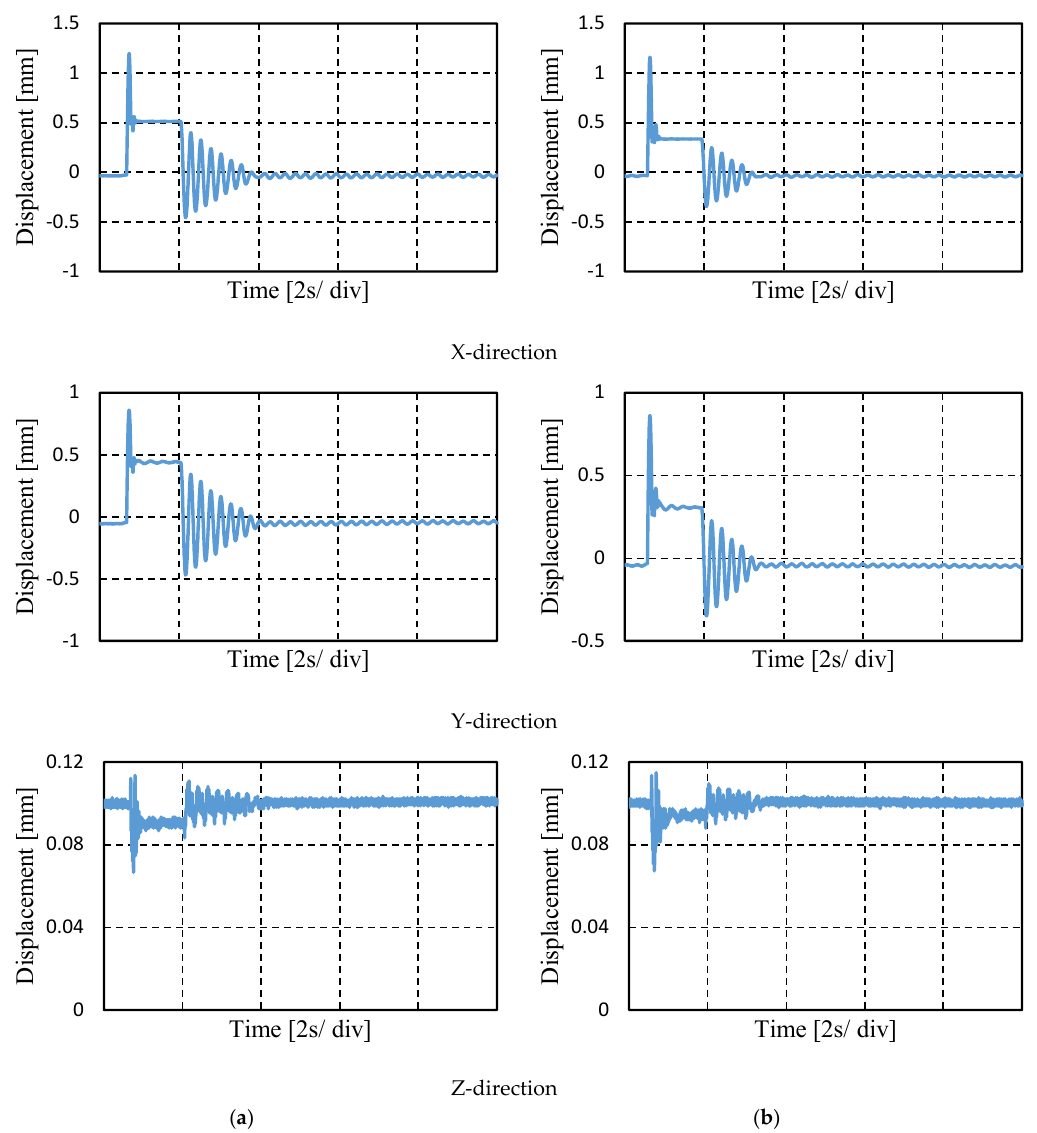
Figure 11. Effect of parameter q on settling time with the same control current, ∆ I = 0.1 A, ( a ) q = 30 and ( b ) q = 70.